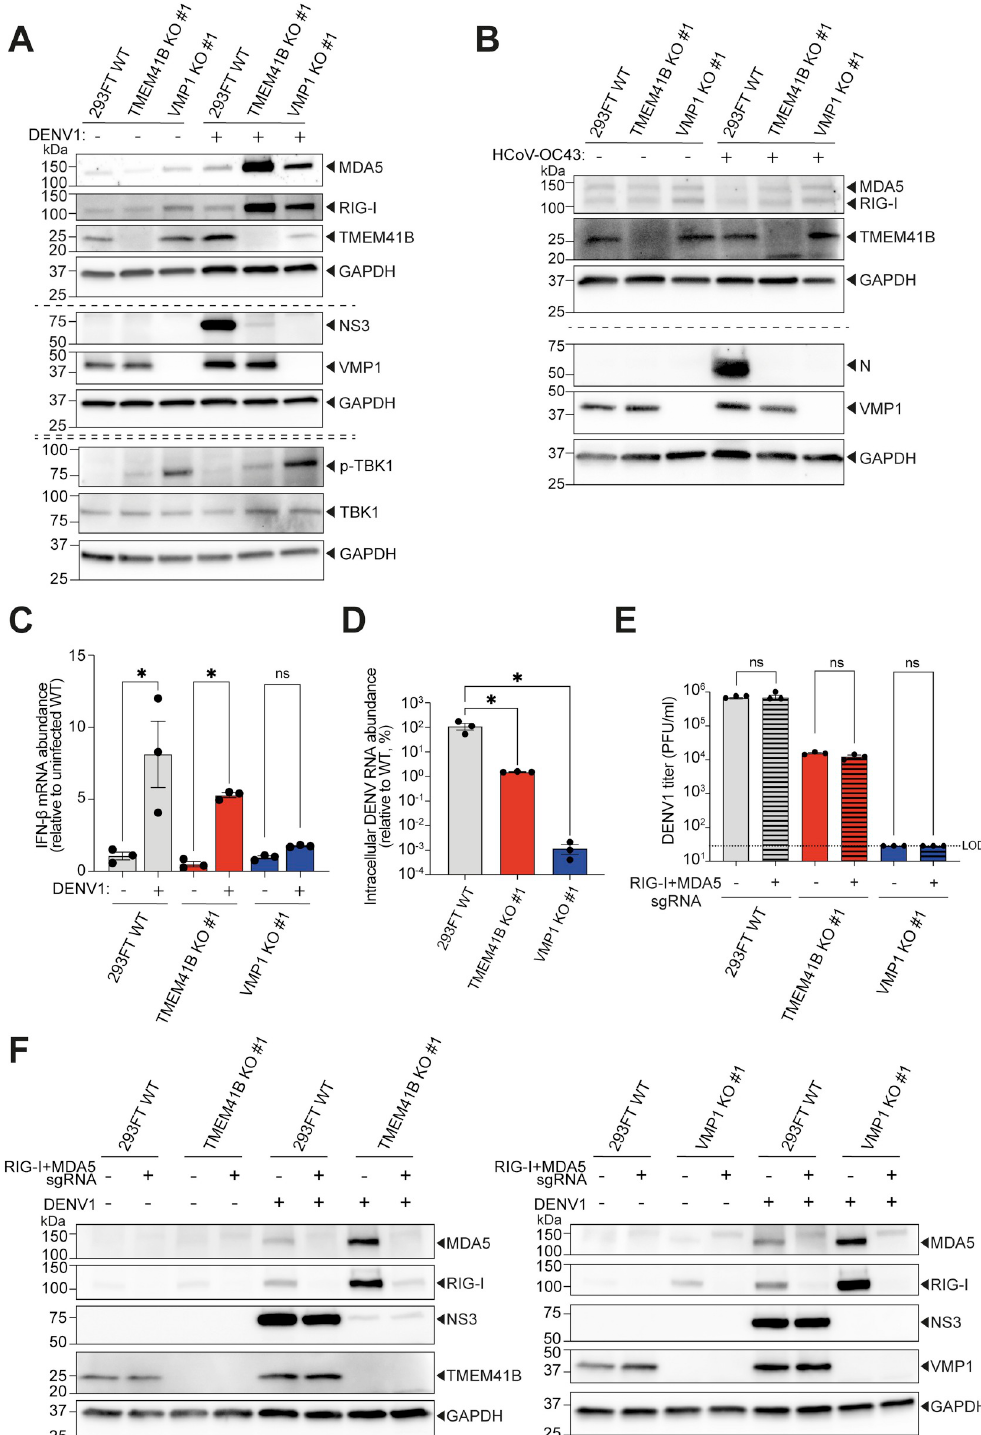
Fig 2. Upregulation of dsRNA sensors in 293FT TMEM41B KO and VMP1 KO cells upon DENV infection. (A) Western blotting analysis to detect RIG-I, MDA5, TBK1, and p-TBK1 protein levels in 293FT WT cells, TMEM41B KO clone #1, and VMP1 KO clone #1, upon DENV infection. Cells were infected with DENV1 at MOI of 1 and lysates were harvested at 48 hours post-infection. (B) Western blotting analysis to detect RIG-I and MDA5 protein levels in 293FT WT, TMEM41B KO clone #1, and VMP1 KO clone #1 cells, upon HCoV-OC43 infection. Cells were infected with HCoV-OC43